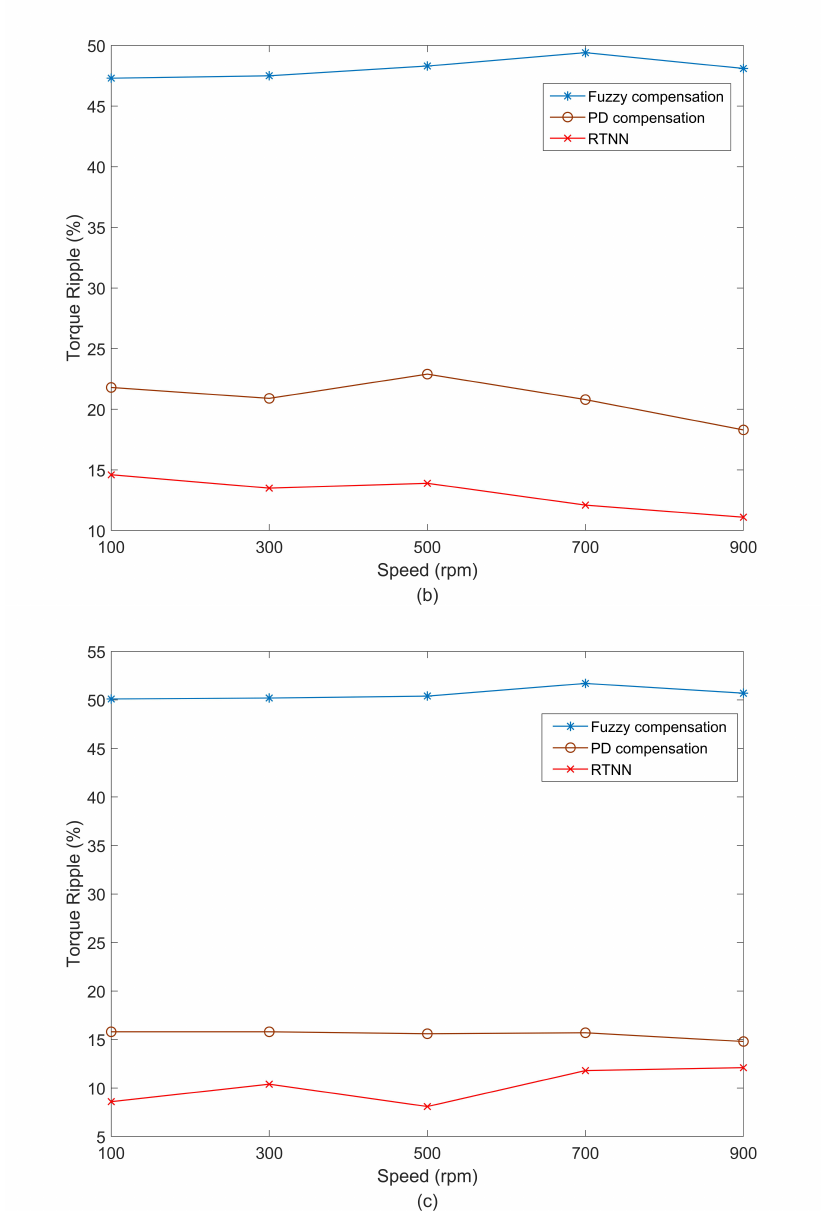
Figure 12. Torque ripple compare under different speeds with ( a ) 1 Nm torque load, ( b ) 2 Nm torque load, and ( c ) 5 Nm torque